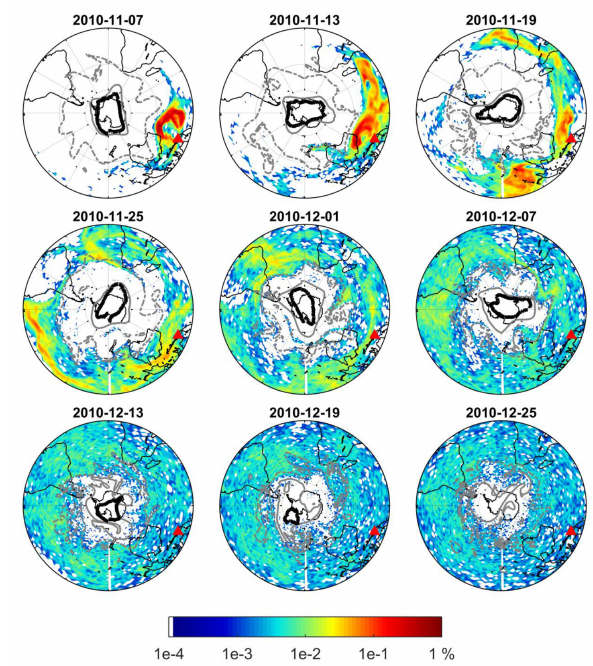
Figure 7. Percentage (%) of air parcels between the isentropic sur- faces of 350 and 480K in proportion to the total number of air parcels released in the Lagrangian forward simulation. All results are at 12:00UTC on selected dates and binned every 2 ◦ in longitude and 1 ◦ in latitude. The black contours indicate the 220DU contour lines of daily mean ozone column density provided by OMI. PV contours marked with gray dashed and solid lines show PV bound- aries on the 350 and 480K isentropic surfaces, respectively (Kunz et al., 2015). The red triangle denotes the location of Mount